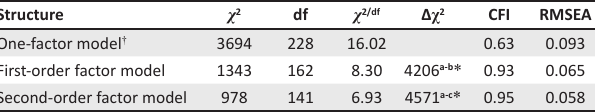
TABLE 15: Comparison of a priori Psychological Capital Questionnaire three- factor structure (adapted factor structure).